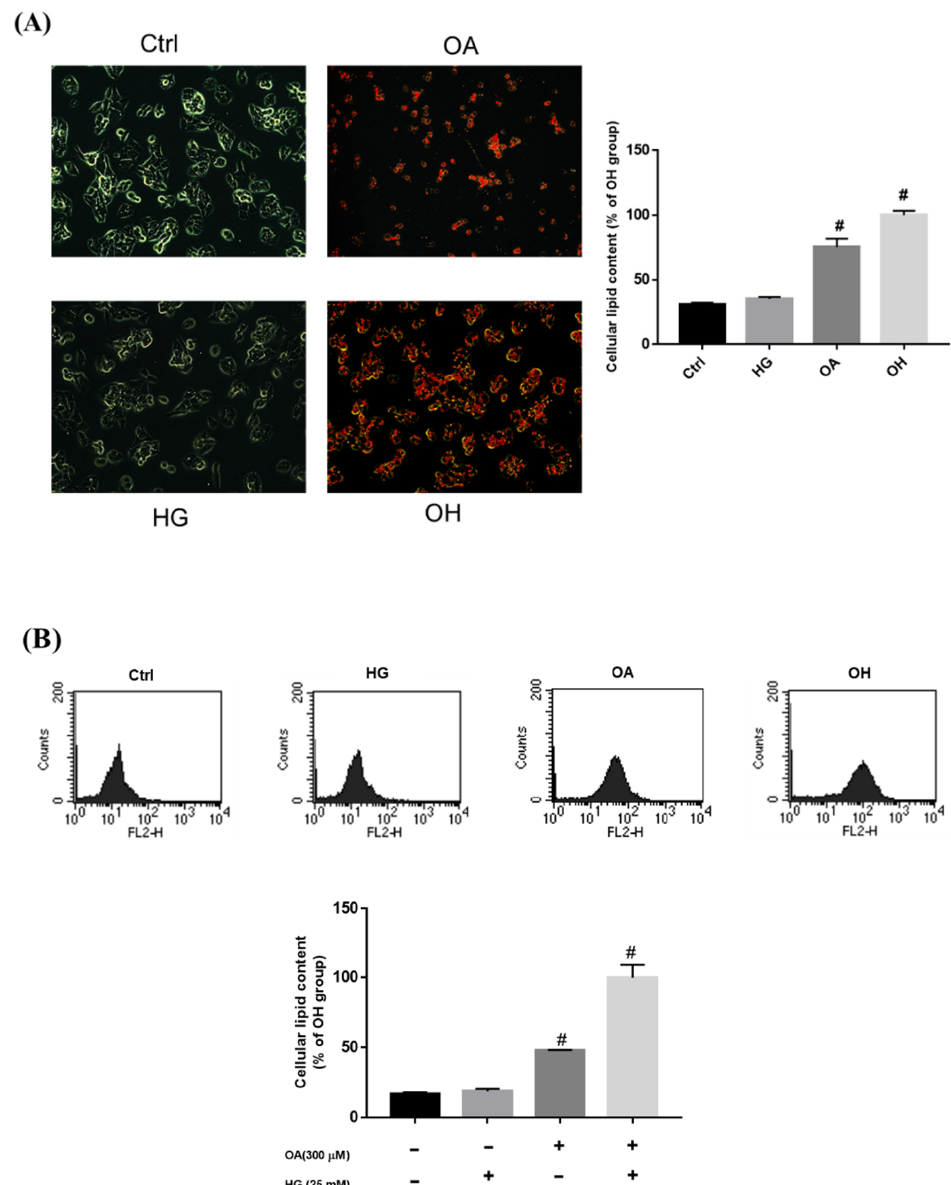
Figure 2. Treatment with OA and HG − induced lipid accumulation in HepG2 cells. HepG2 cells were treated with 25 mM HG, OA, and OH for 24 h. Intracellular lipid accumulation was measured by ( A ) oil red O staining and ( B ) Nile red staining. Values are mean ± SD for three replicates per treatment. # p < 0.05 vs. the control group.